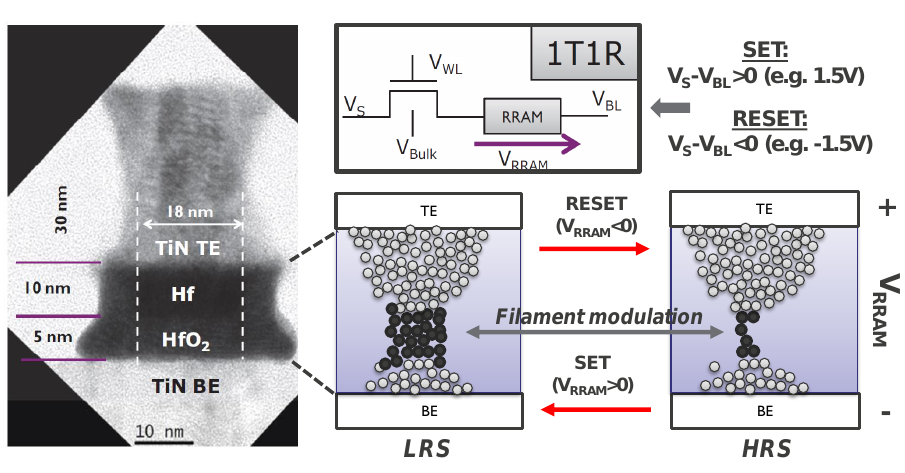
Figure 2: The cross section of an oxygen-based RRAM and the concept of filament modu- lation resulting from set/reset operations. The RRAM devices using in the experiments are in a one-transistor one-resistor (1T1R) configuration. The black dots in the right-bottom figure shows the mobile defects located in the current-limiting filament constriction. The white dots shows the mobile defects forms the top and bottom conductive part in the